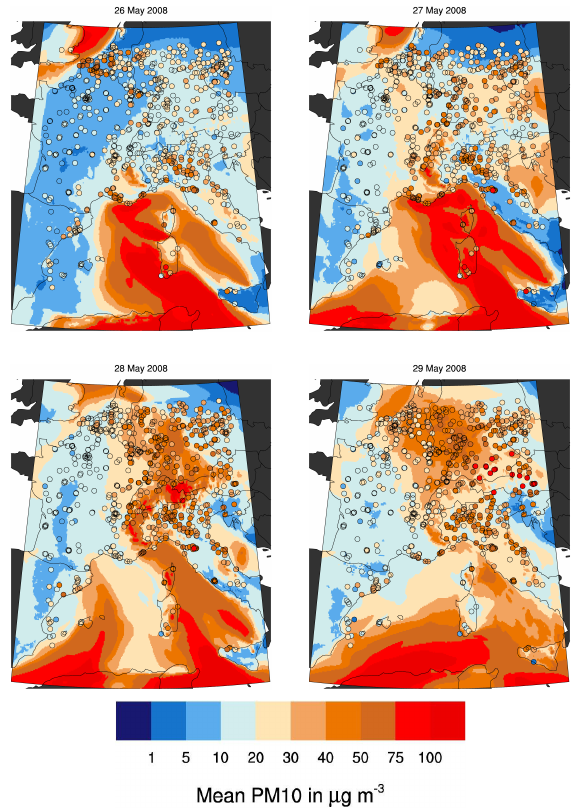
measurements(dots)(EEA,2011)fortheindividualdaysduringthedustevent.